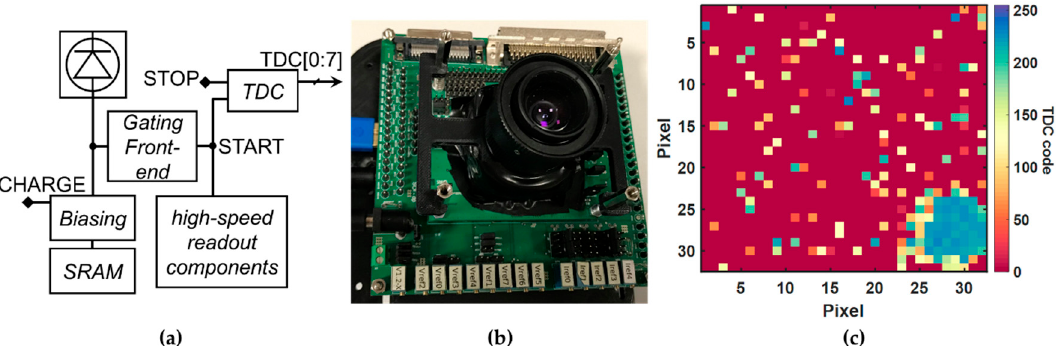
Figure 1. ( a ) Pixel block diagram with a single-photon avalanche diode (SPAD), and driving and processing electronics; ( b ) SuperEllen module; ( c ) a sample frame depicting different photon arrival times on the